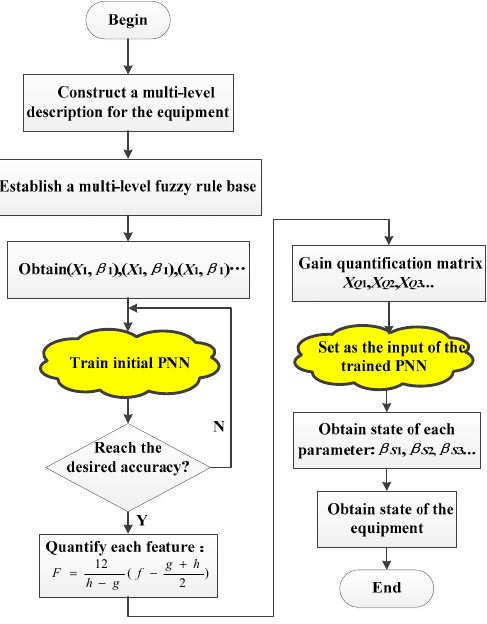
Figure 3. Flowchart of the proposed method.